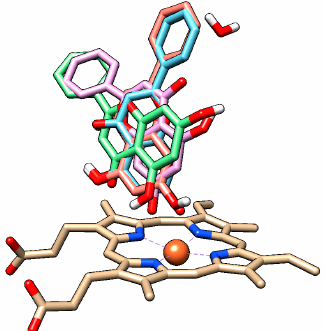
Figure 6. Comparison of the docked alpha-naphthoflavone with all water molecules removed (green), docked alpha-naphthoflavone in presence of HOH 733 (yellow), and crystallographic alpha- naphthoflavone (brown) in vicinity of cytochrome P450 1A2 heme. Oxygen atoms are depicted in red, nitrogen atoms in blue, hydrogen atoms in white, and heme iron in orange.